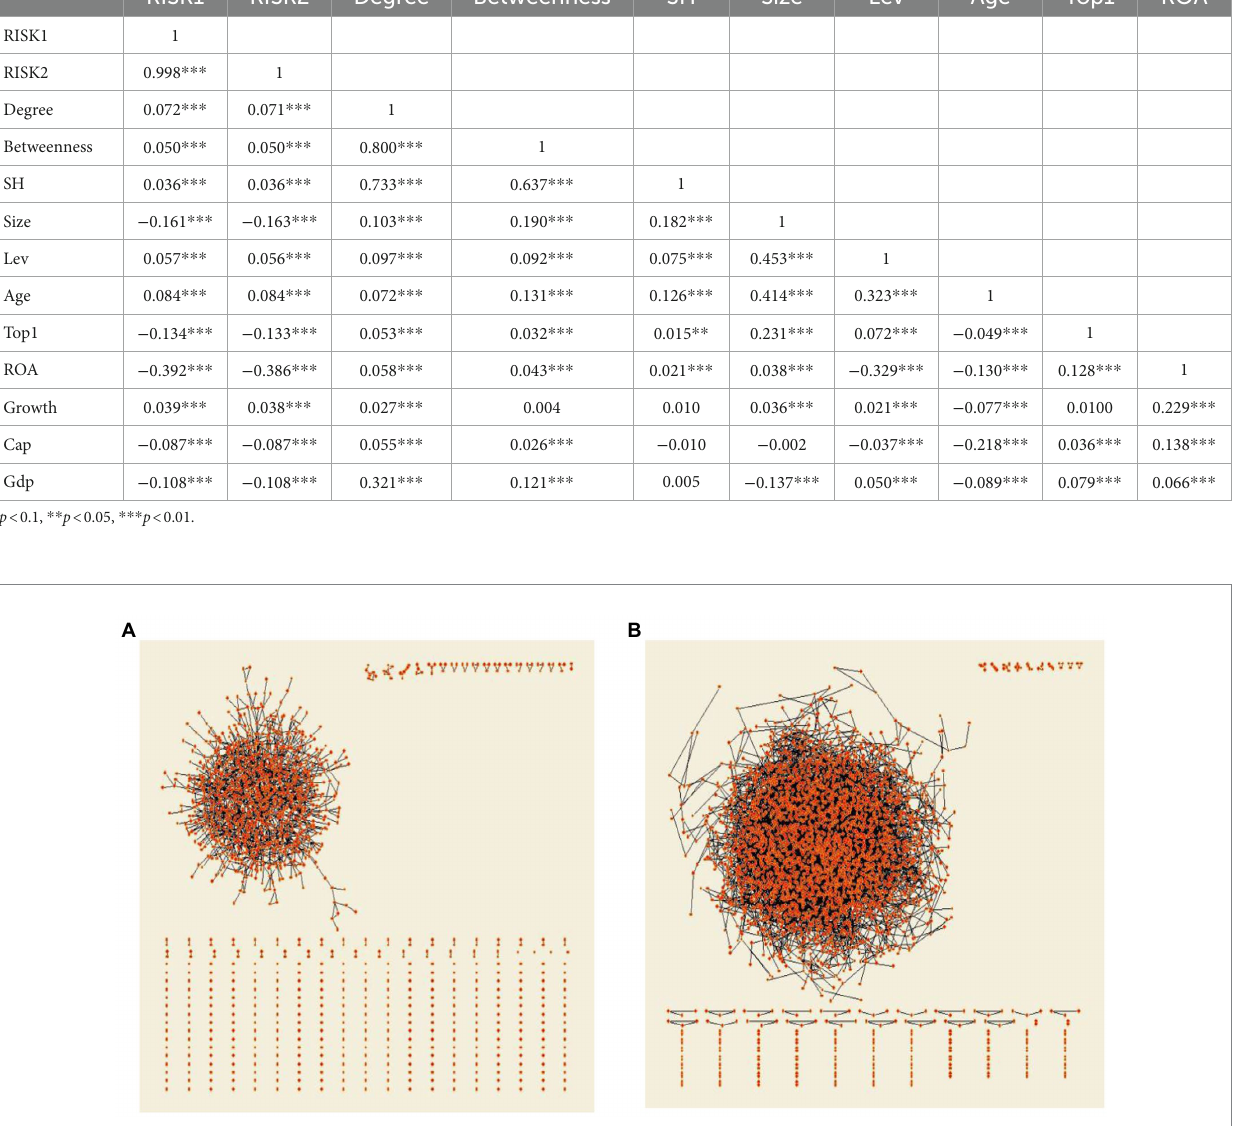
Chinese listed companies has become more complex and closer as time goes on.